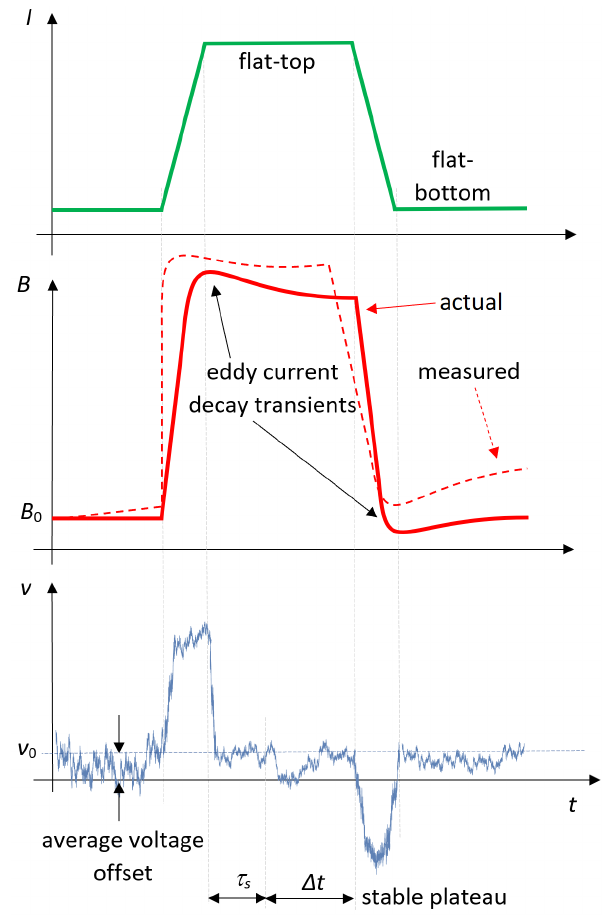
Figure 1. Schematic representation of a synchrotron magnet cycle. The offset voltage v o determines an increasing deviation of the field measurement from the actual